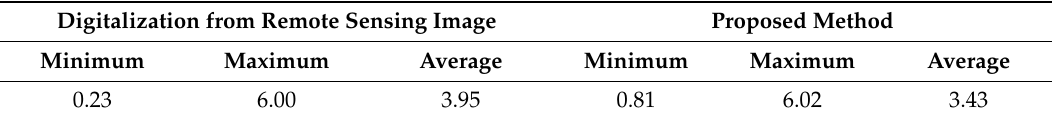
Table 5. Minimum, maximum, and average Dg of digitalization and proposed method (m).